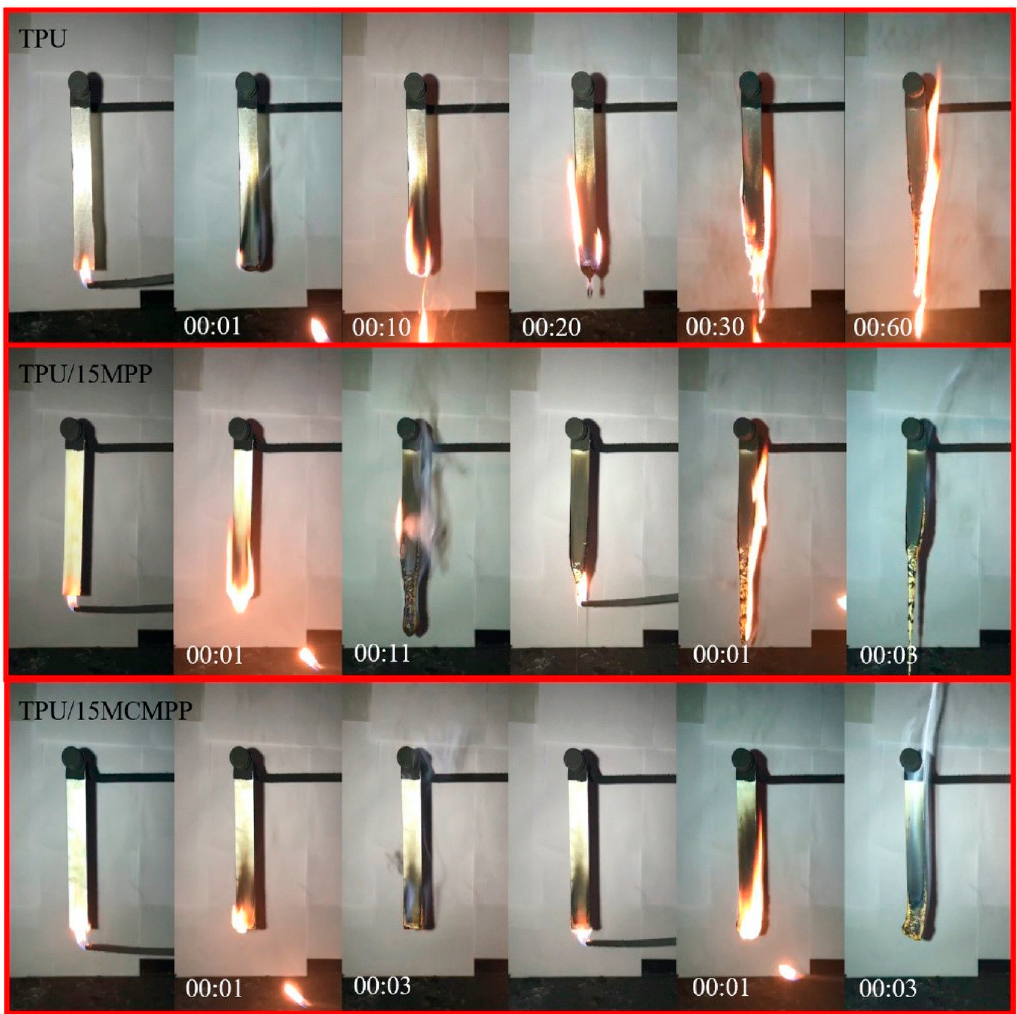
Figure 4. Video screenshots of TPU (thermoplastic polyurethane), TPU / MPP (thermoplastic polyurethane containing 15 wt. % of melamine polyphosphate) and TPU / MCMPP (thermoplastic polyurethane containing 15 wt. % of melamine polyphosphate microencapsulated by toluene diisocyanate crosslinked carboxymethyl chitosan) composites during UL-94 testing. Reprinted with permission from [32]. Copyright 2019, Elsevier.